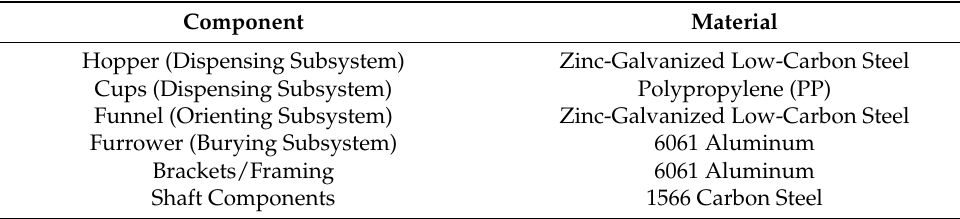
Table 4. Material Specifications of unique prototype components.